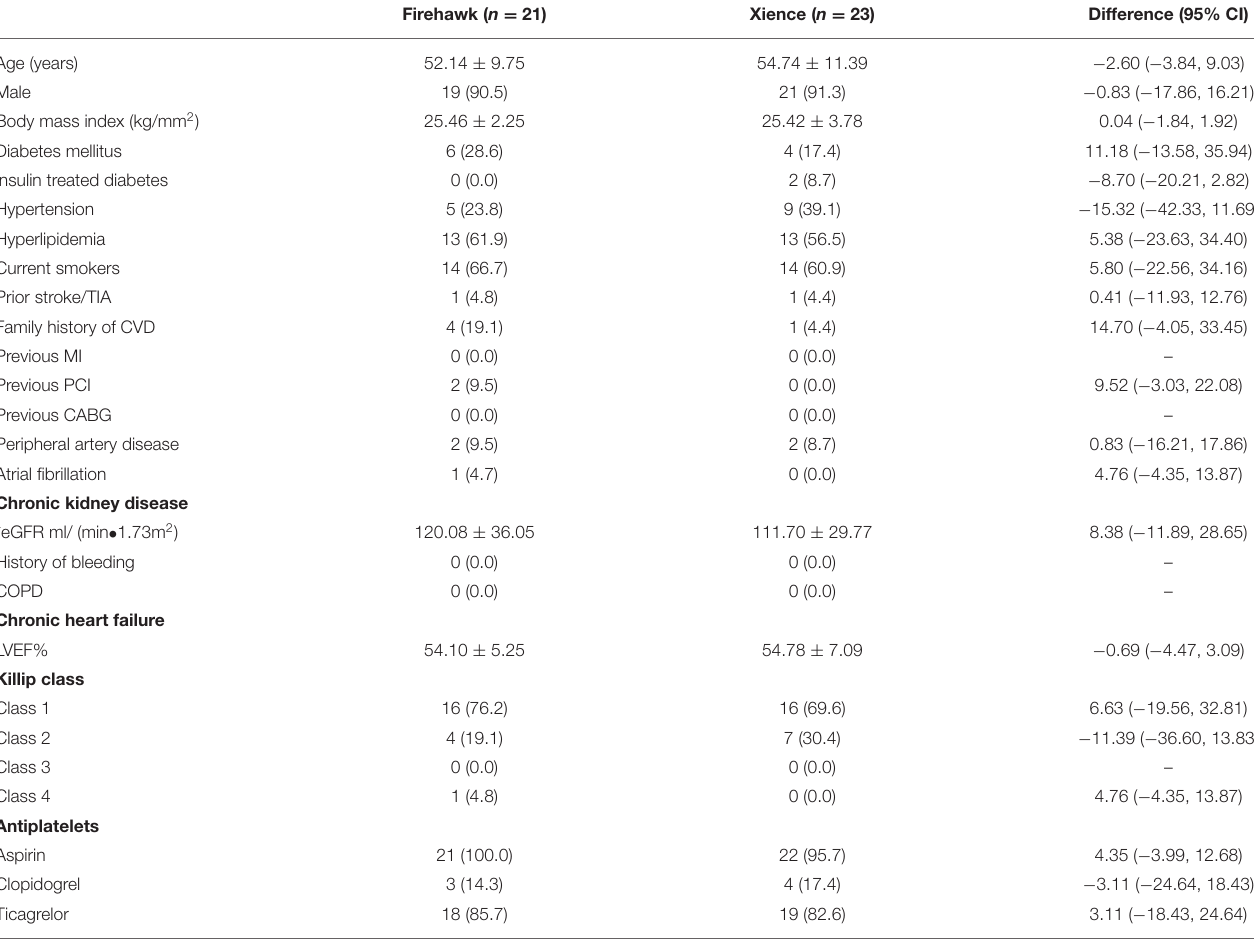
TABLE 1 | Baseline characteristics in the Firehawk stent and Xience stent